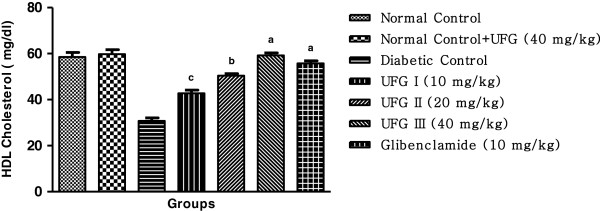
Effect of umbelliferone β-D-galactopyranoside on level of HDL (High density lipoprotein) cholesterol at different concentrations on STZ induced diabetic rats, compared to diabetic control group rats; values are mean ± SEM; n = 6;
c
P < 0.05;
b
P < 0.01;
a
P < 0.001; P > 0.05 is considered as non-significant (ns).